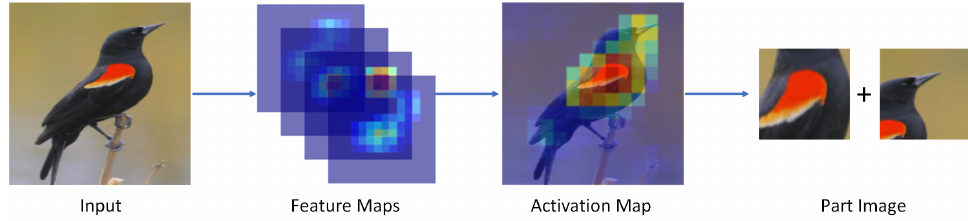
Figure 3. The key part images are obtained by cropping in the object image, obtaining the feature map of the object image, overlaying it by channels to obtain the attention map in a two-dimensional plane, and calculating the average attention value size of each region in the attention map using a sliding window. The regions with large average attention values represent the important regions of the target; hence, we crop out these regions in the object image as the local area